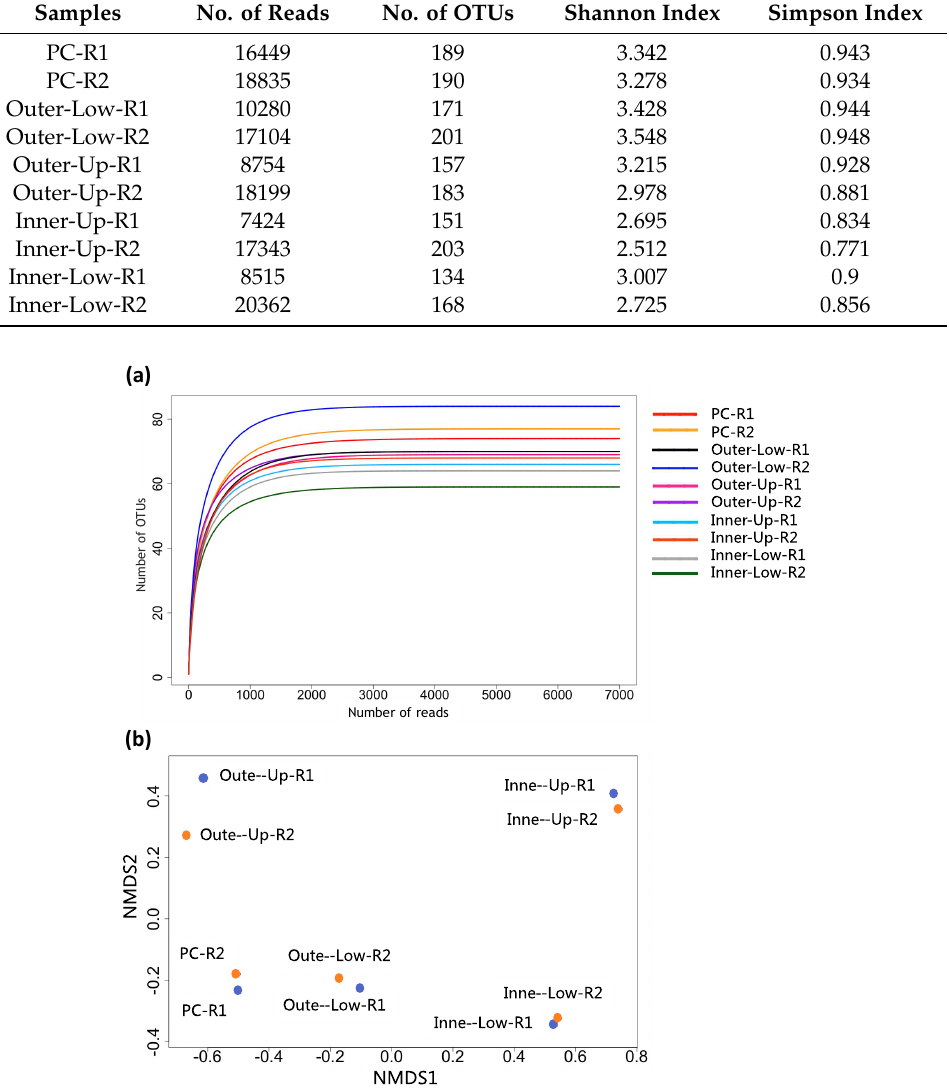
Figure 3. ( a ) Rarefaction curves and ( b ) Non-metric multidimensional scaling (NMDS) plot showing the relationships between the microbial communities of different biofilm samples obtained from the anodes of the bioelectrochemical system-trickling filter (BES-TF) reactors R1 and R2. PC: planktonic cells, Outer-Low: Outer biofilm of the lower part of the anode (submerged in wastewater), Outer-Up: Outer biofilm of the upper part of the anode (not submerged in the wastewater), Inner-Low: Inner biofilm of the lower part of the anode (submerged in wastewater), Inner-Up: Inner biofilm of the upper part of the anode (not submerged in the wastewater).